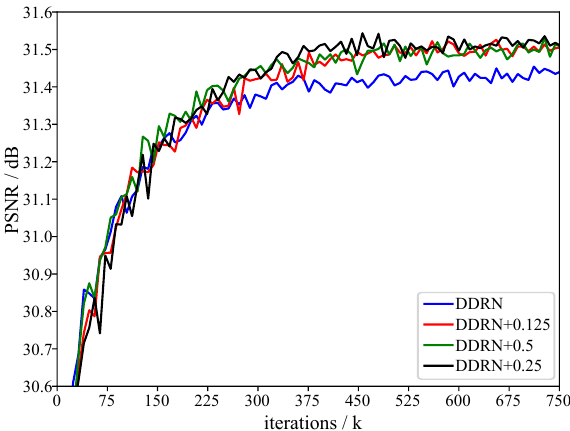
Figure 7. Training process for different distillation ratios by the scale of 4. DDRN + represents the improved module with MSPU embedded at different ratios on the basis of the basic module. In particular, DDRN denotes the improved module with the distillation ratio α of 0, which is actually the basic module.